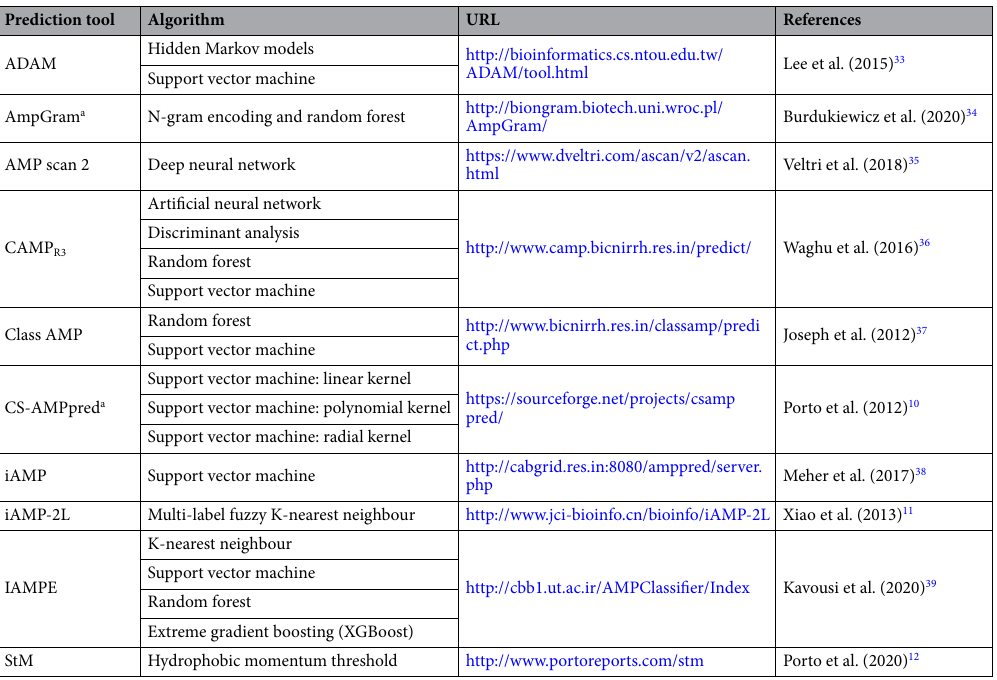
Table 3. List of the used prediction tools (and algorithms within some tools). a Used on local computer, not on